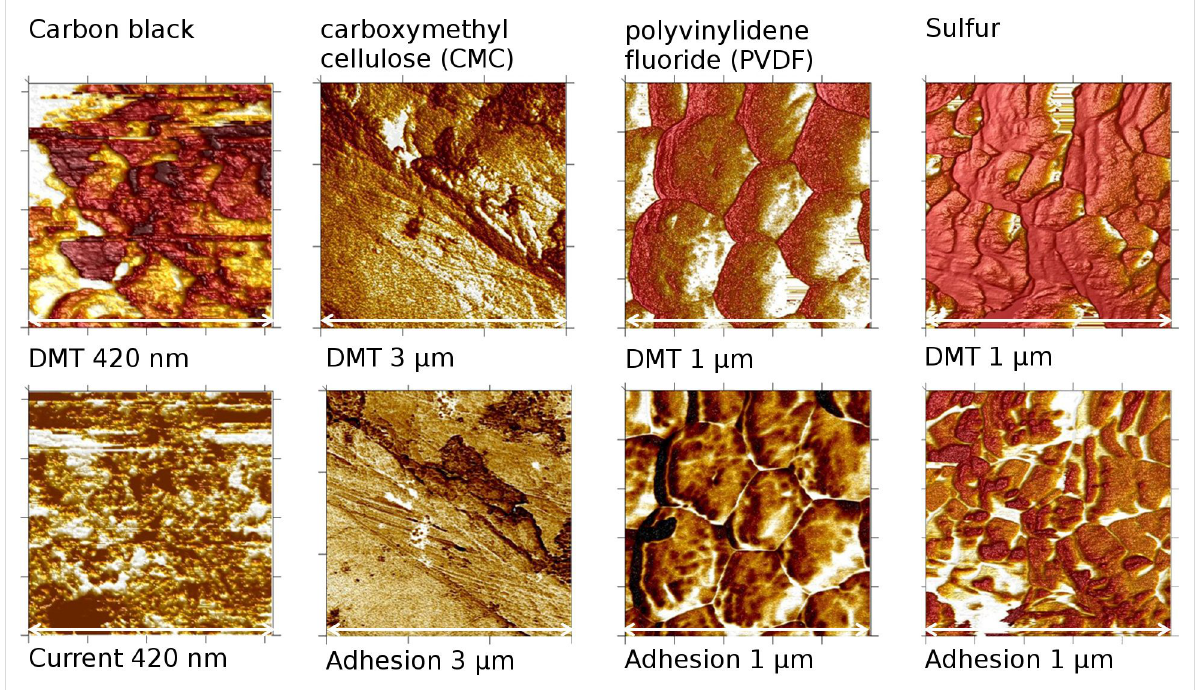
Figure 4: Mapping of DMT modulus and current/adhesion of basic materials used for cathode preparation from AFM, brighter colours indicate higher values. The size of the scale bar is given below each image.